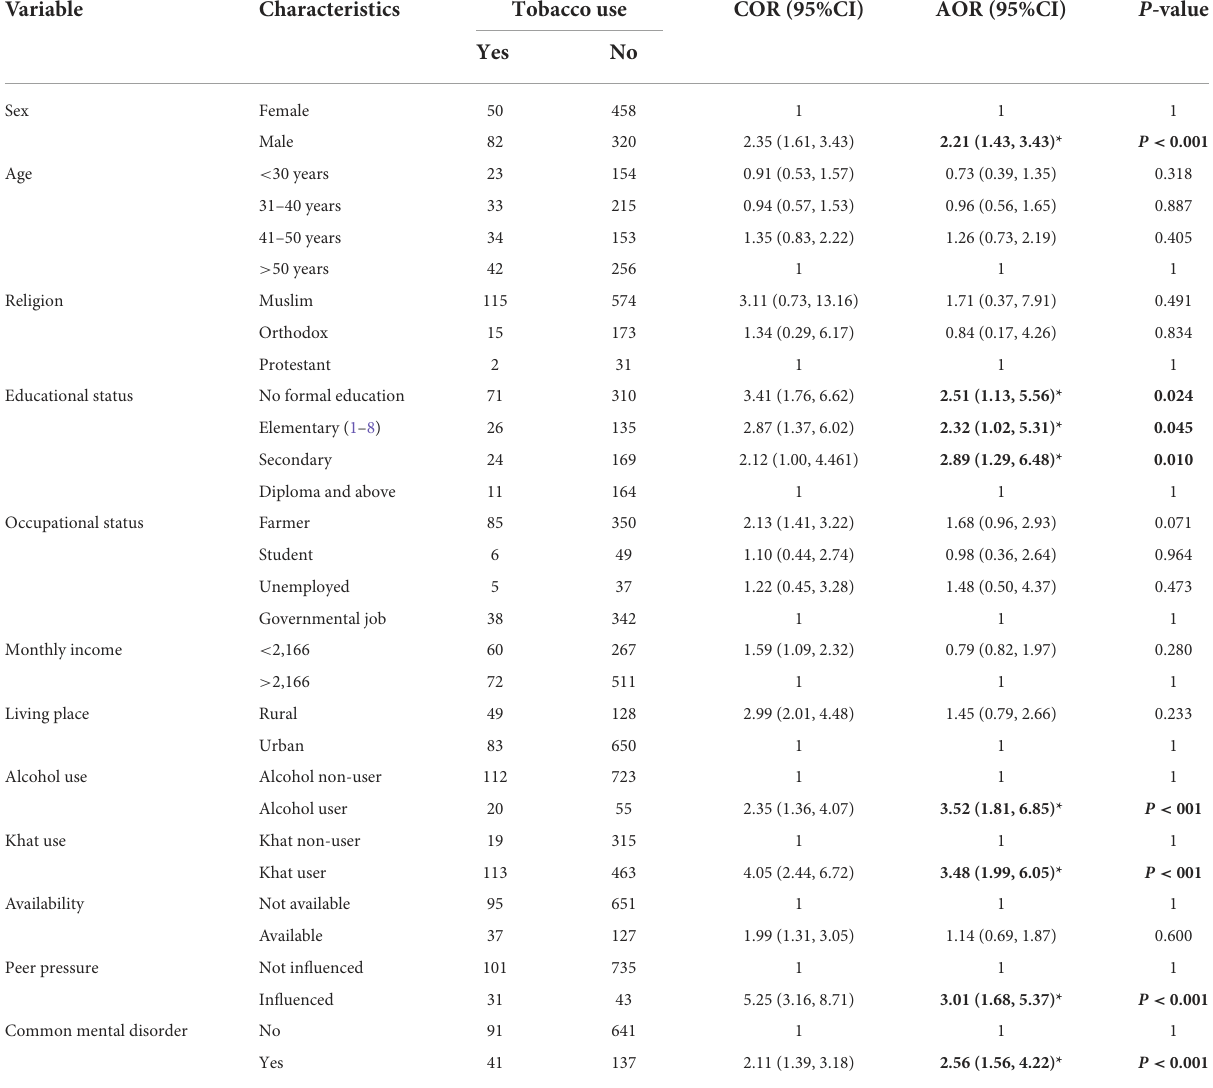
TABLE 3 Factors associated with tobacco use among adult residents of Harari regional state, Ethiopia, 2022 ( N = 910).